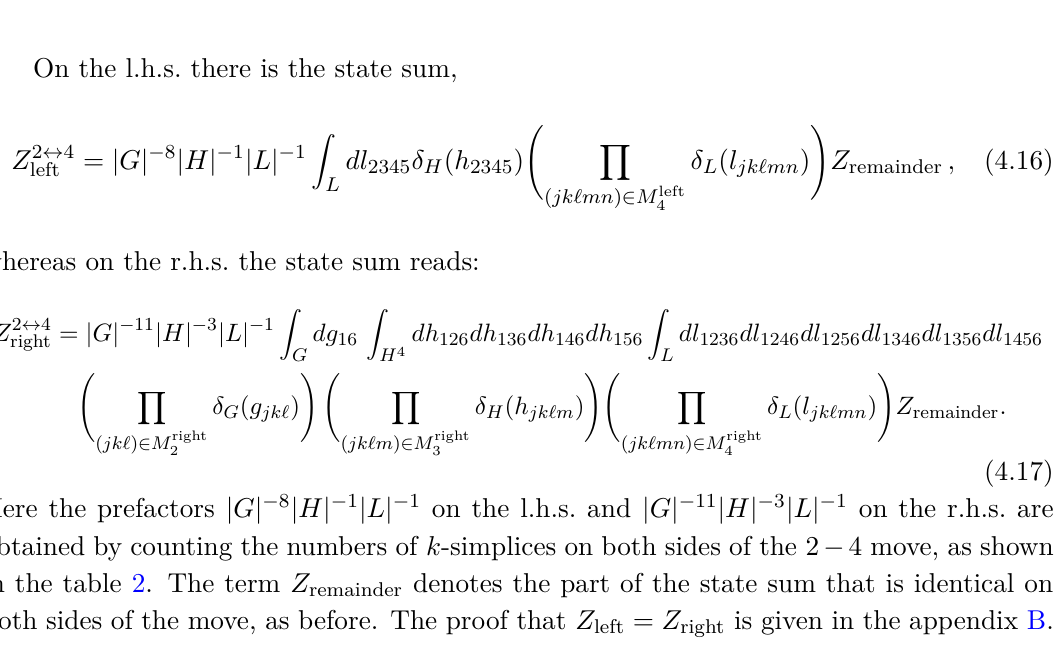
Table 2 . Number of vertices | Λ 0 | , edges | Λ 1 | , triangles | Λ 2 | , tetrahedrons | Λ 3 | , and 4-simplices | Λ 4 | on both sides of the 2 ↔ 4